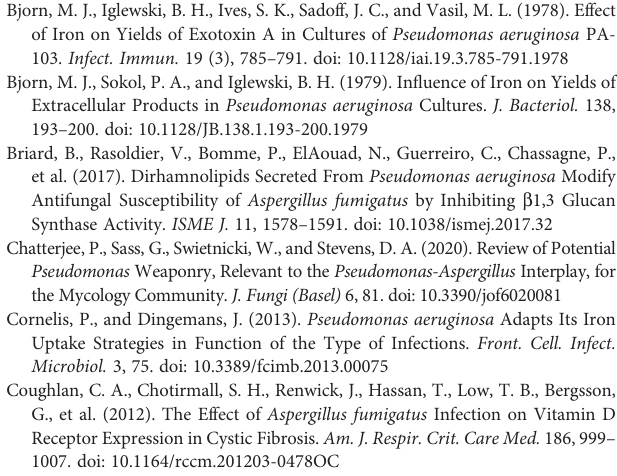
Supplementary Table 1 | P. aeruginosa mutants used in this